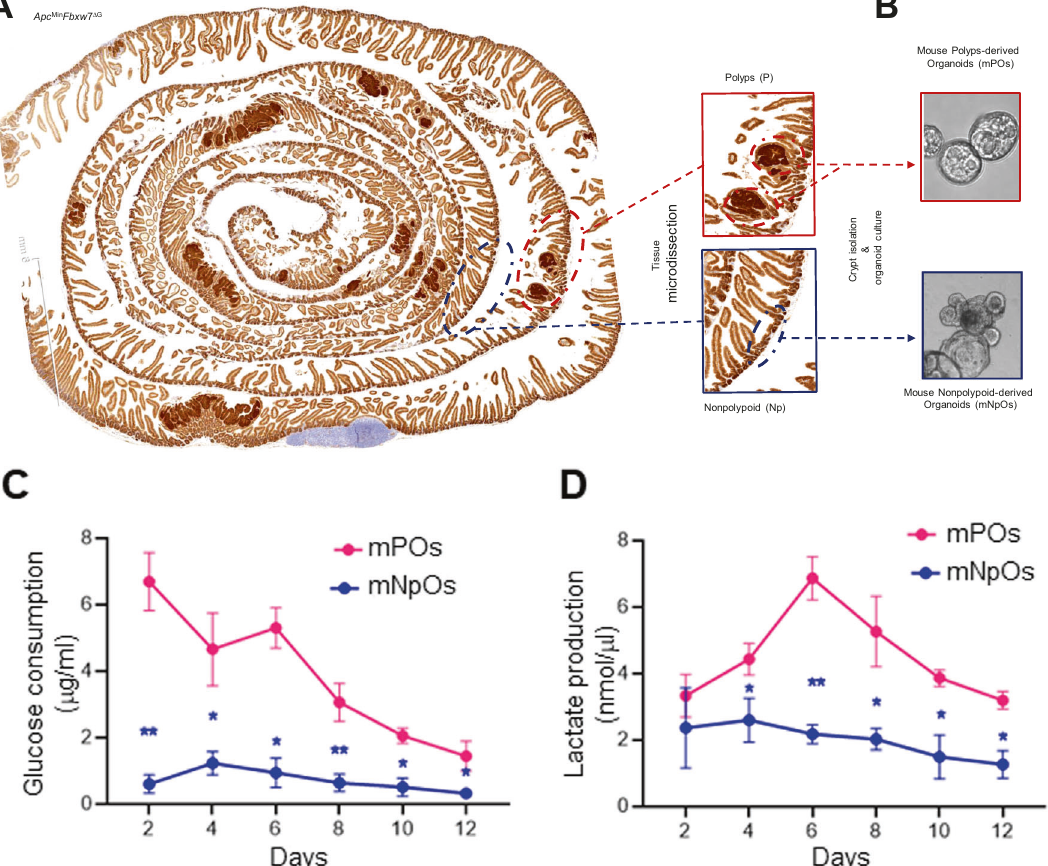
Fig. 1 Murine duodenal Apc Min Fbxw 7 Δ G polyps-derived organoids (mPOs) versus non-polyps-derived organoids (mNPOs) cultures signi fi cantly increased glucose consumption and lactate production. A Intestinal tumour development of 3 weeks double-mutant Apc Min Fbxw7 Δ G mice. Dashed lines indicate intestinal polyps (red) and healthy non-polypoid (blue) dissected for mPO and mNPOs cultures. Bar, 100 µm. Boxes indicate magni fi ed the selected intestinal polyps and non-polypoid crypts. B Representative live images of duodenal organoids grown for 5 days from isolated polyps and non-polyps crypts. C Murine duodenal Apc Min Fbxw7 Δ G -POs had a signi fi cantly higher glucose consumption rate, and lactate production ( D ) than duodenal Apc Min Fbxw7 Δ G -NPOs, indicating a metabolic shift towards anaerobic glycolysis. The consumed glucose ( μ g/ml) was calculated by subtracting the medium glucose at each time point (2 to 12 days) from fresh media glucose. The lactate concentration (nmol/ μ l) was calculated in the medium at each time point (day 2 to day 12). Experiments were performed in six-well plates, seeded ~200 organoids/well for each organoid type, and repeated on at least three independent occasions using three separate litters just about 3 weeks born by different times and different breeding (Male Apc Min Fbxw7 Δ G X Females Fbxw 7 fl / fl ) pairs. Results were normalised to the level of glucose and lactate of each organoid type medium. ( n = 3; * P < 0.05; ** P < potential target of miR-26a and miR-141 (data not shown). We then found increased expression of SPOCK1 (Fig. 4A) but not SPOCK2 (Fig. 4B) was associated with poor overall survival (OS) in human colon adenocarcinoma (COAD). Further stage plot analysis (Fig. 4C). Murine Spock 1 3 ′ UTR binding sites for miR-135 were signi fi -